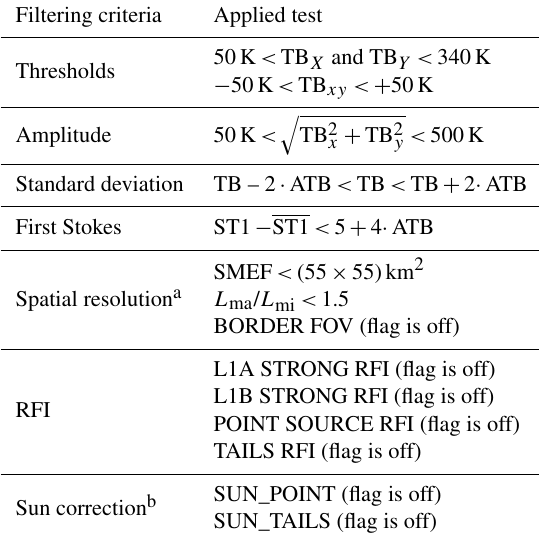
Table 1. List of applied filtering criterion used on brightness tem- perature products prior to